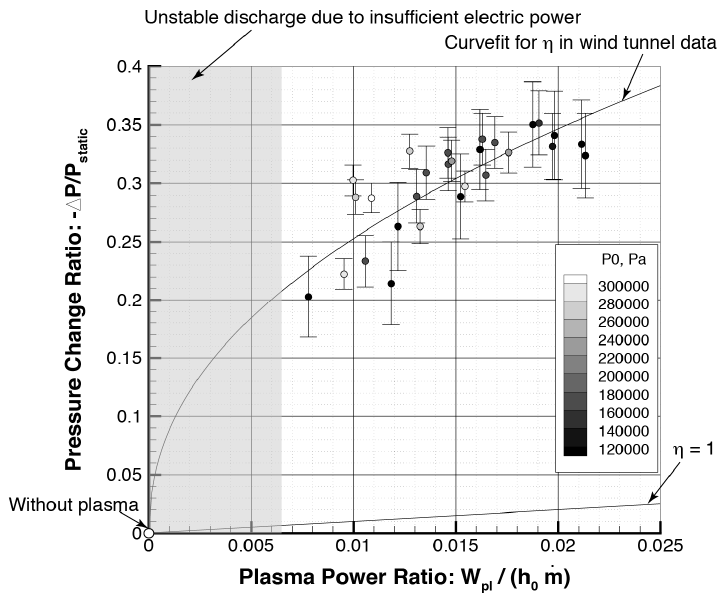
Figure 9. Task-related effectiveness η .